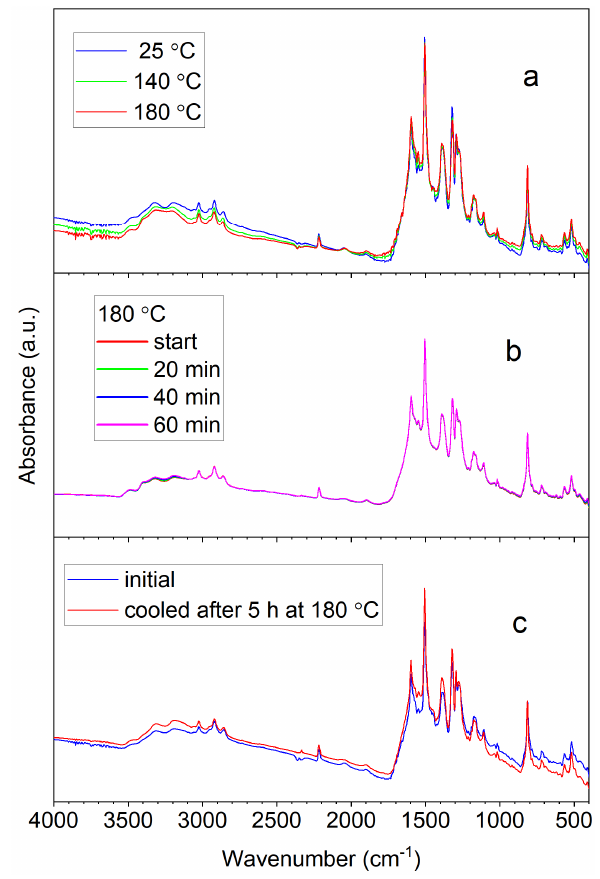
Figure 3. Temperature dependence of FTIR spectra of bTAThDaz ( a ), time dependence of the IR spectrum of bTAThDaz at 180 °C ( b ) and IR spectrum of bTAThDaz at 180 °C before and after annealing at 180 °C ( c ).